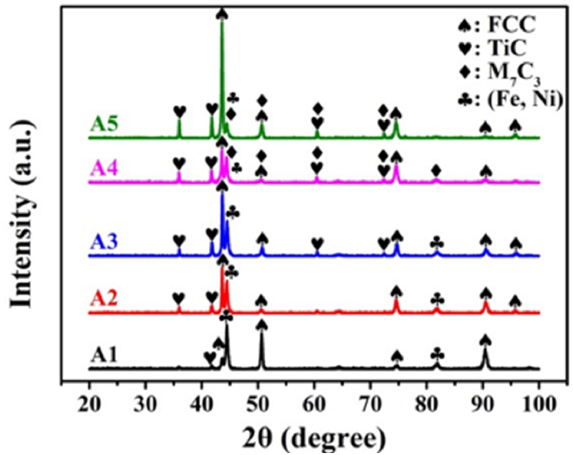
Figure 3. XRD phase analysis of A1, A2, A3, A4, and A5. Table 2. EPMA analysis of the chemical composition of each phase in A1, A2, A3, A4, and A5. Elements ( at.% ) Alloys